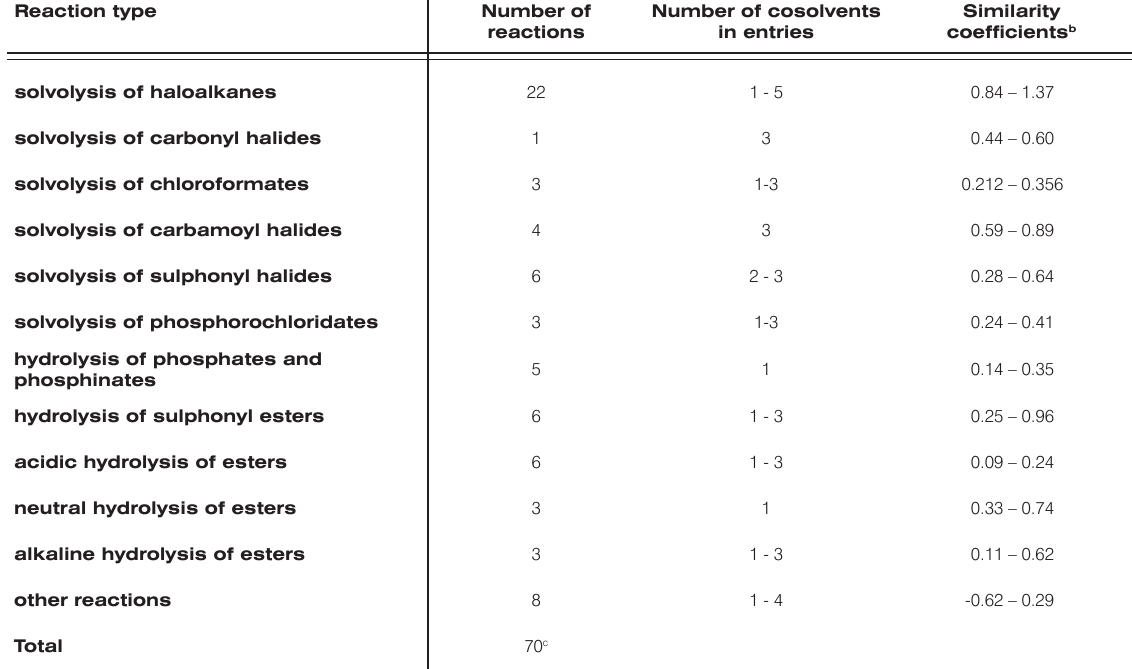
Table 1. Survey of the similarity analysis of kinetic data a